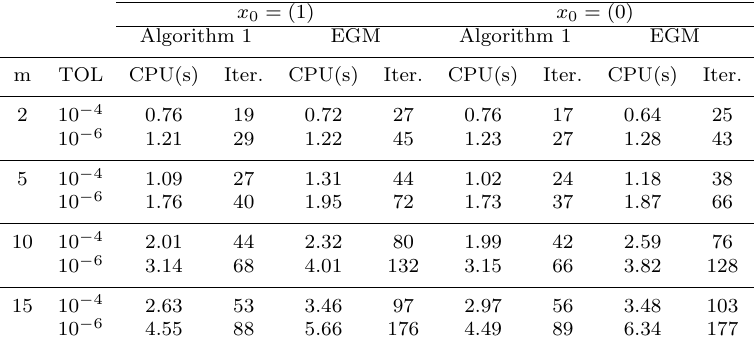
Table 1. Table 1. The results for Algorithm 1 and EGM in Experiment 1